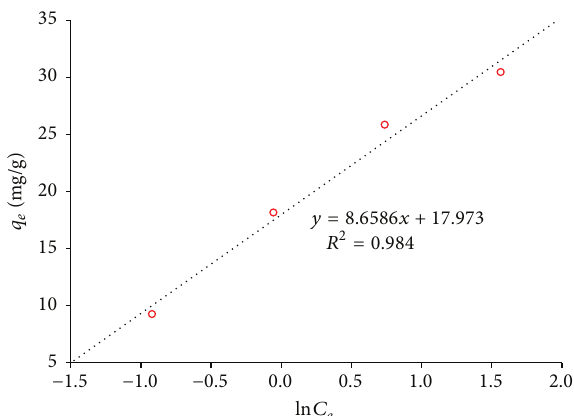
Figure12:Temkinisothermplotsforadsorptionofcopperionsonto